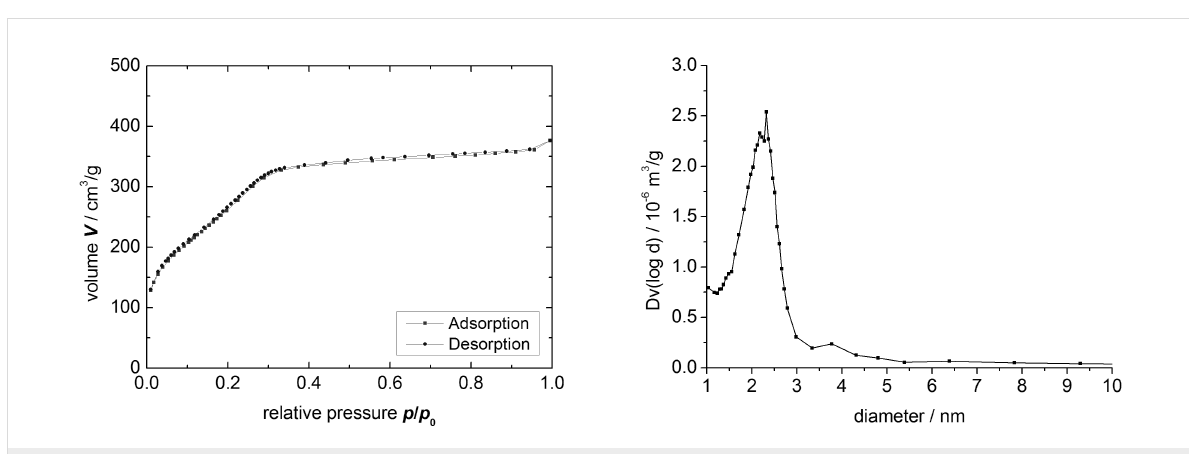
Figure 4: Sorption isotherm (left) and pore size distribution (BJH plot) (right) of MCM-ACR .